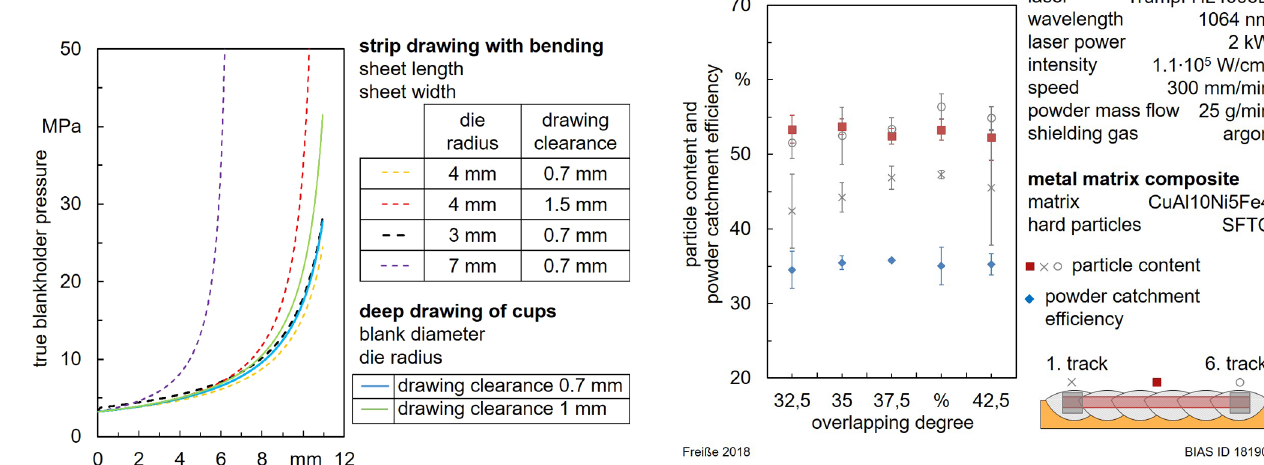
Fig. 7. Variation of overlapping degree in laser melt-injected multitracks showing a constant particle content and powder catchment ef fi